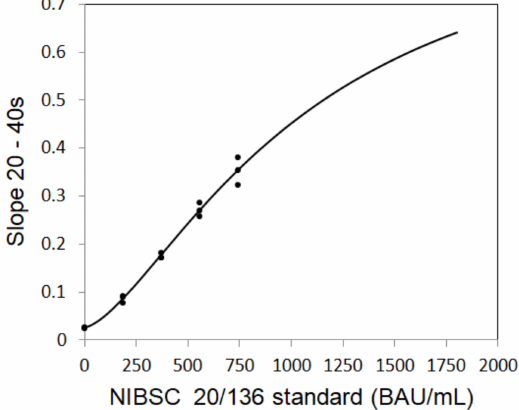
Figure 4. Establishment of four parameter logistics (4PL) standard